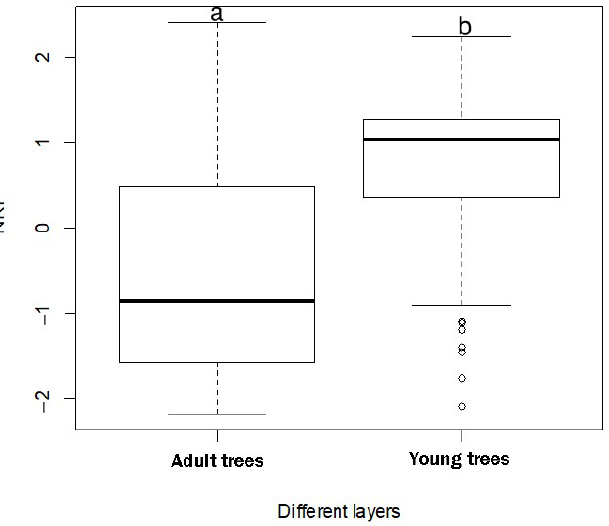
Figure 2. Net relatedness index ( NRI ) of tree adults and saplings in 69 plots in secondary forests on Mount Lao, northern China. In box plots, data are shown as median (line) ± the interquartile range (boxes), ±1.5 times the interquartile range (whiskers). Different letters ‘a’ and ‘b’ indicate significant differences at the p ≤ 0.05 level.